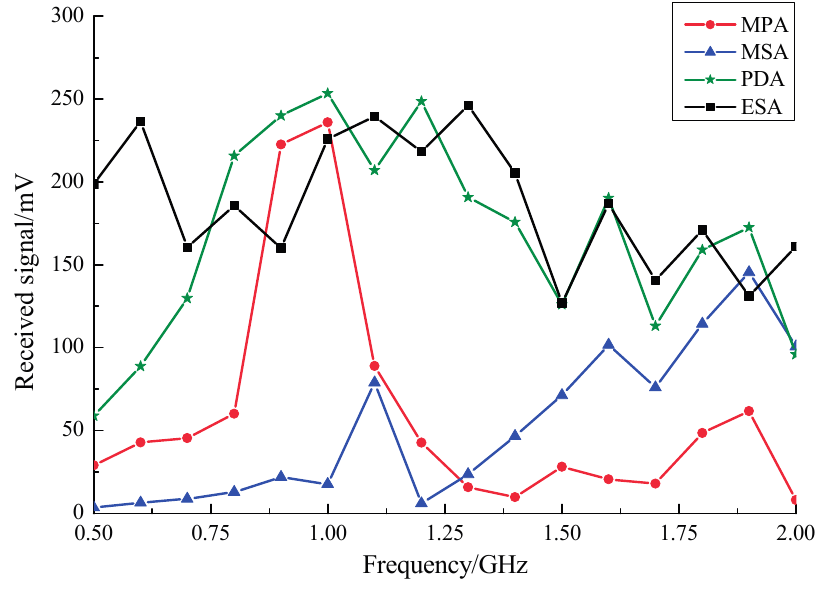
Figure 12. Frequency sweep results from testing in the GTEM